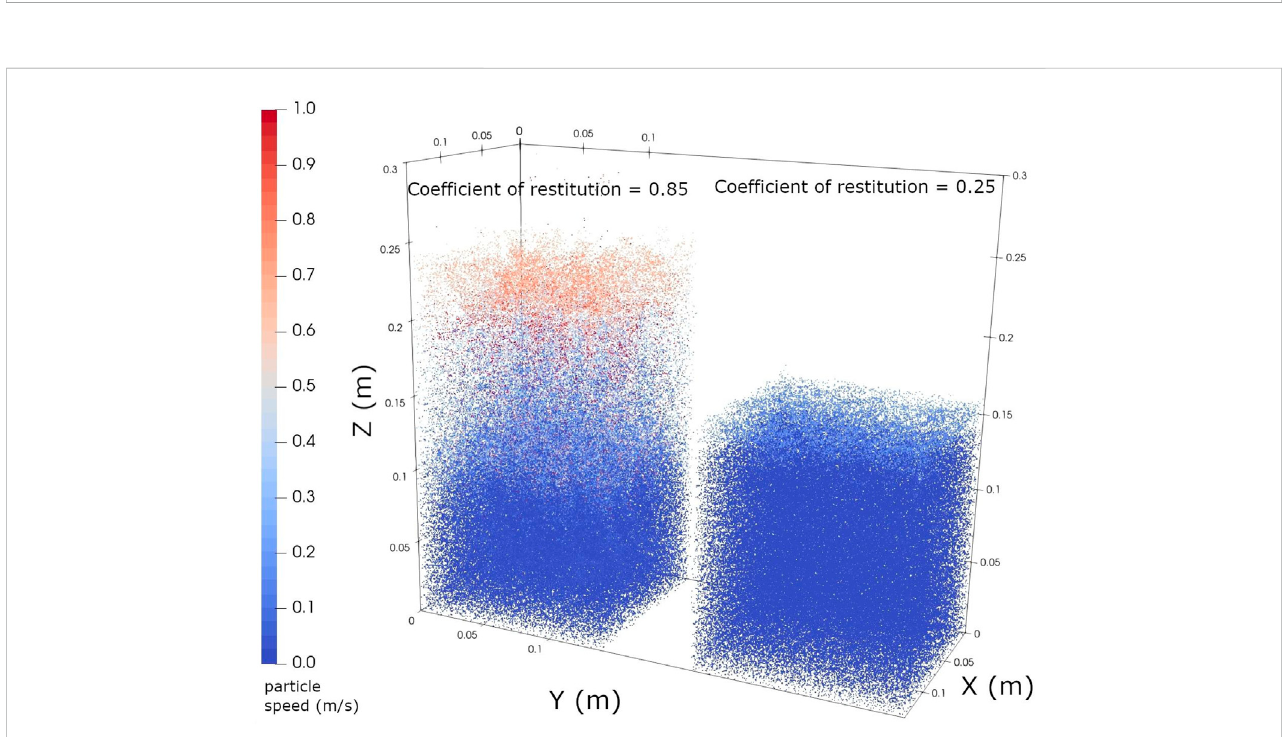
Comparison of the particle distribution with different coef fi cient of restitution at